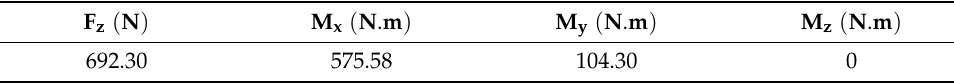
Figure 4. Applied loads on the wheel hub carrier bracket. Table 2. Applied loads on the wheel hub carrier bracket.